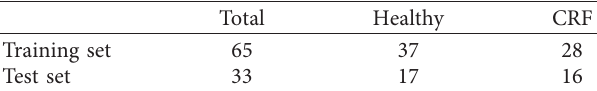
Table 1: Division of CRF patients and control